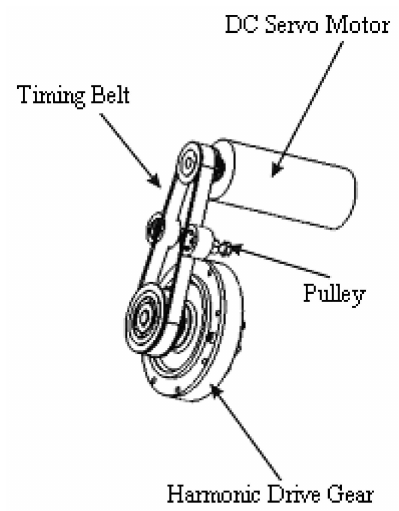
Figure 2. Joint gear